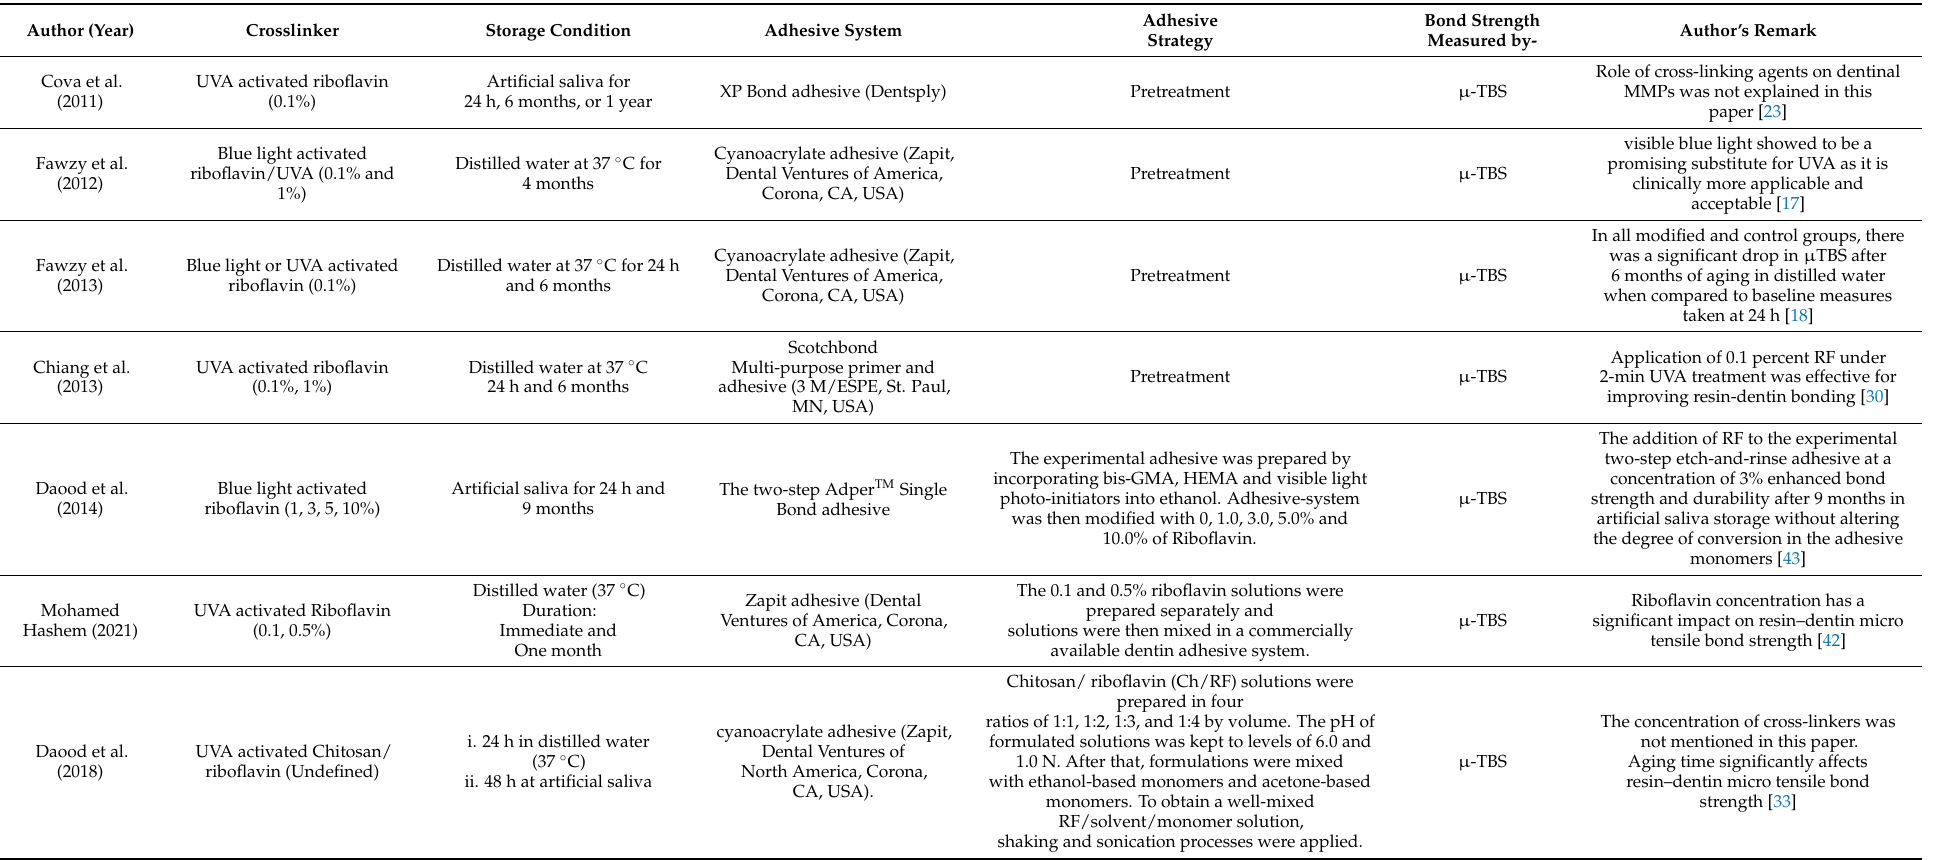
Table 2. Data extraction from included